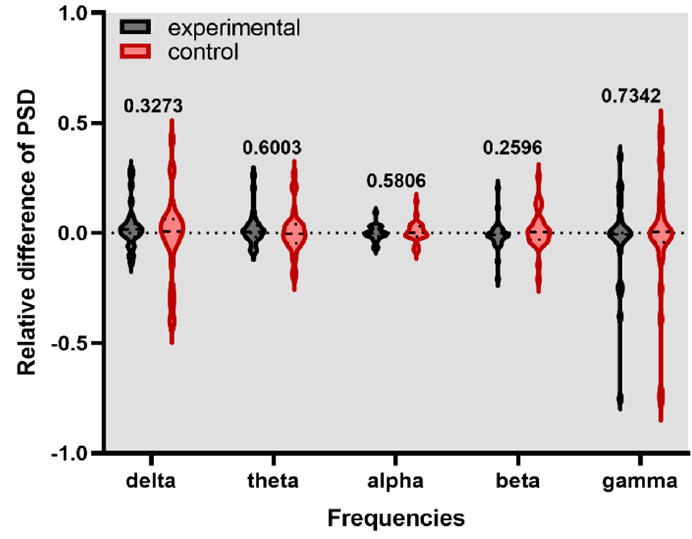
Figure 5. Relative difference of PSD for F2 channel during the digit span task.